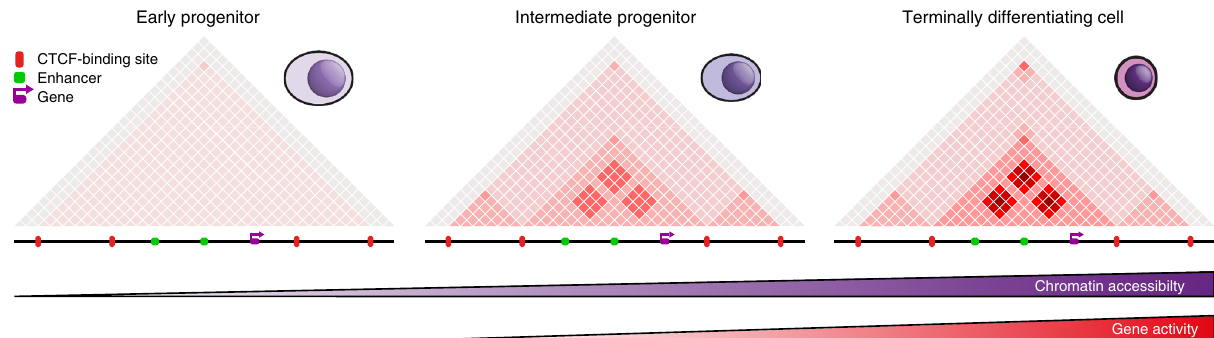
Fig. 6 Graphical Summary. Based on our fi ndings, we propose a model in which TADs are established very early in differentiation. During lineage commitment, tissue-speci fi c open chromatin sites are established within these domains. This is followed by the formation of smaller sub-domains within TADs, in which enhancers and promoters form interactions. Through differentiation, accessibility and speci fi c interactions between enhancers and promoters are gradually increased, concomitant with upregulation of gene